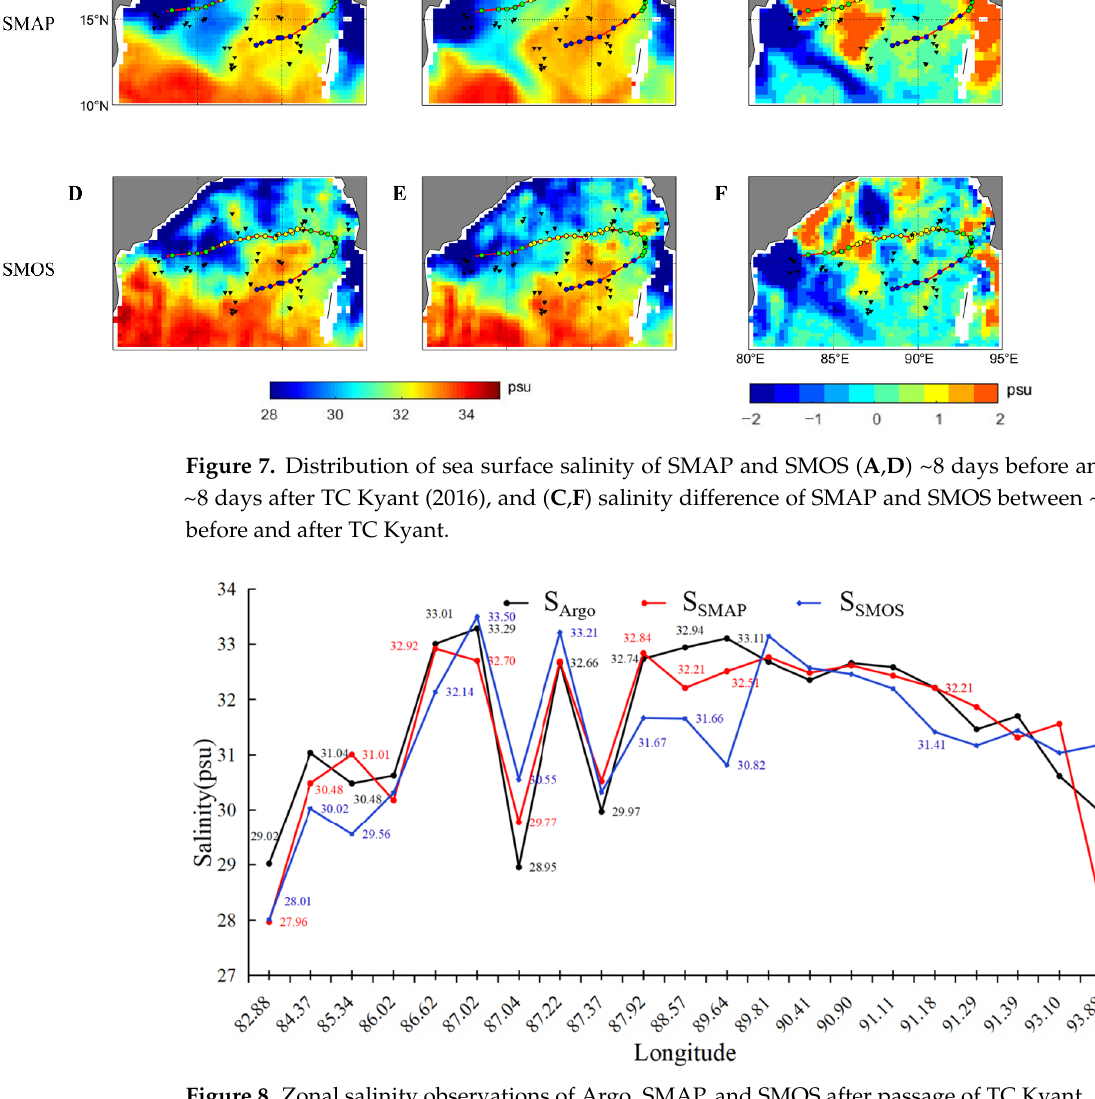
Figure 8. Zonal salinity observations of Argo, SMAP, and SMOS after passage of TC Kyant.